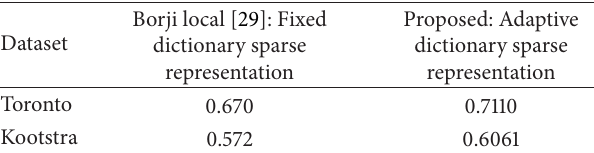
Table 5: sAUC score comparison using fixed [29] and adaptive sparse representation (proposed) for CSD saliency.